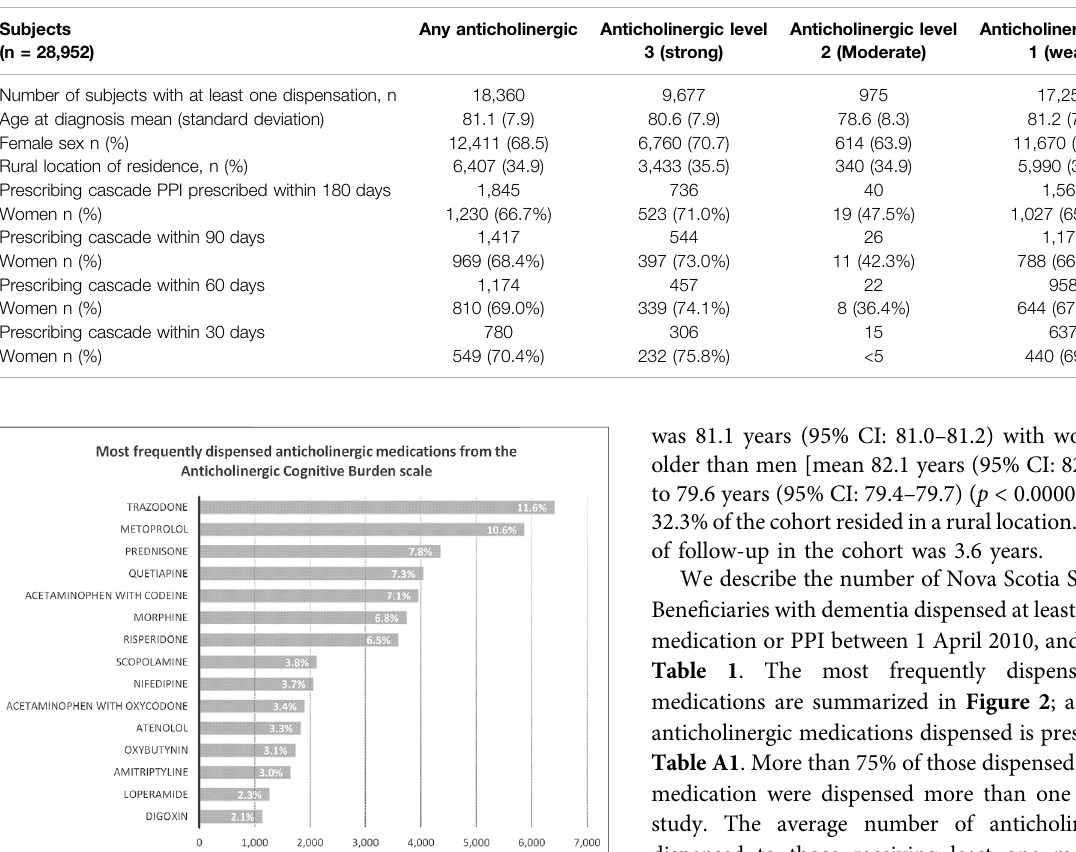
Frontiers in Pharmacology |